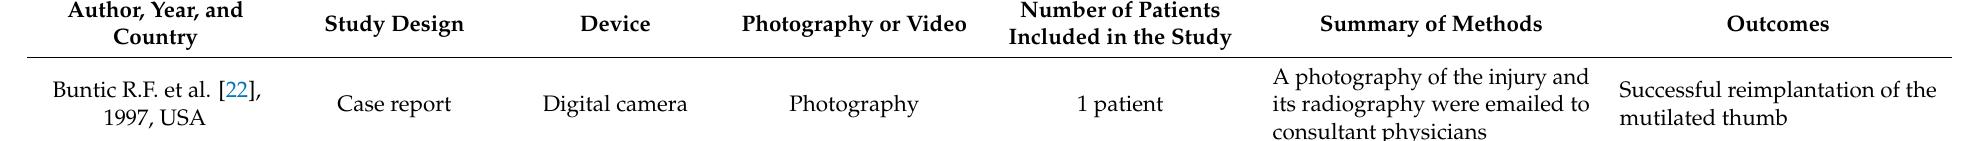
Table 1. Summary of included studies. Information on the authors, study design, devices used, type of multimedia file, and number of patients were collected. A summary of the authors’ methods and most relevant outcomes are also